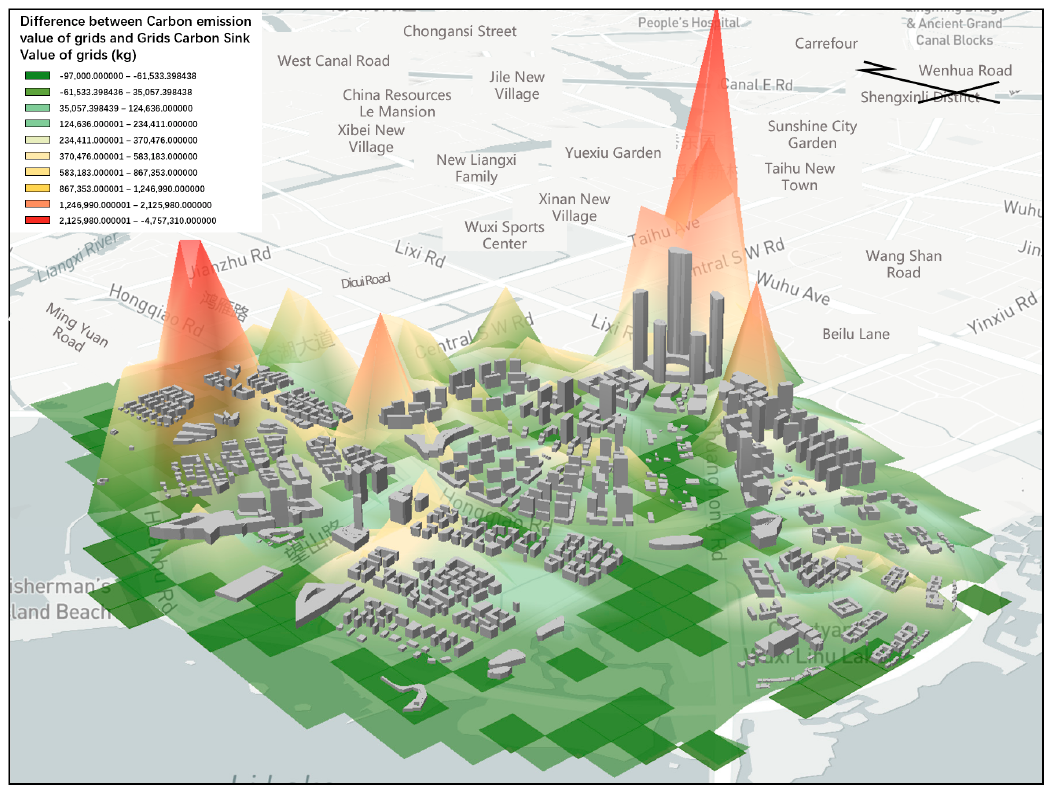
Figure 8. Carbon emission and carbon sink distribution of Lihu Future City design scheme (Visualization based on mapbox platform).